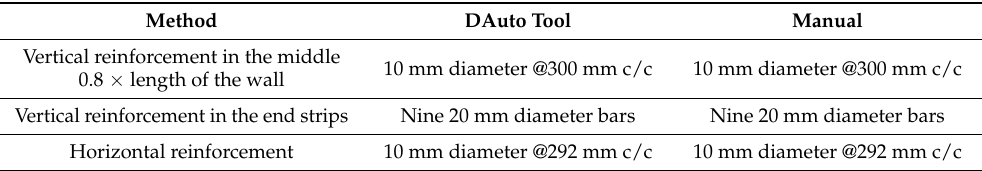
Table 10. Comparison of reinforcement